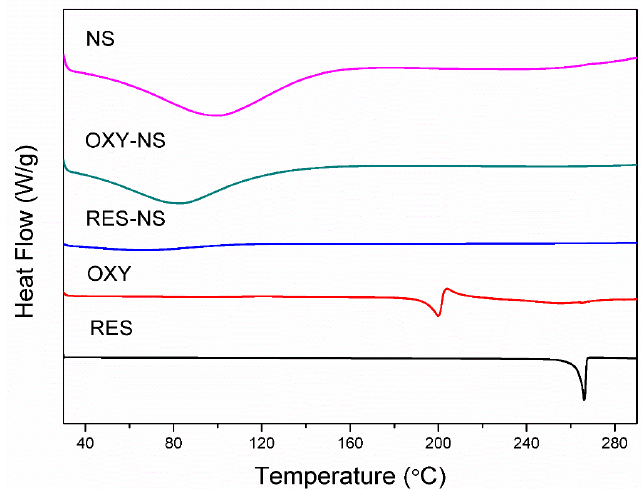
Figure 5. DSC thermograms of RES, OXY, RES-NS, OXY-NS and blank NS.